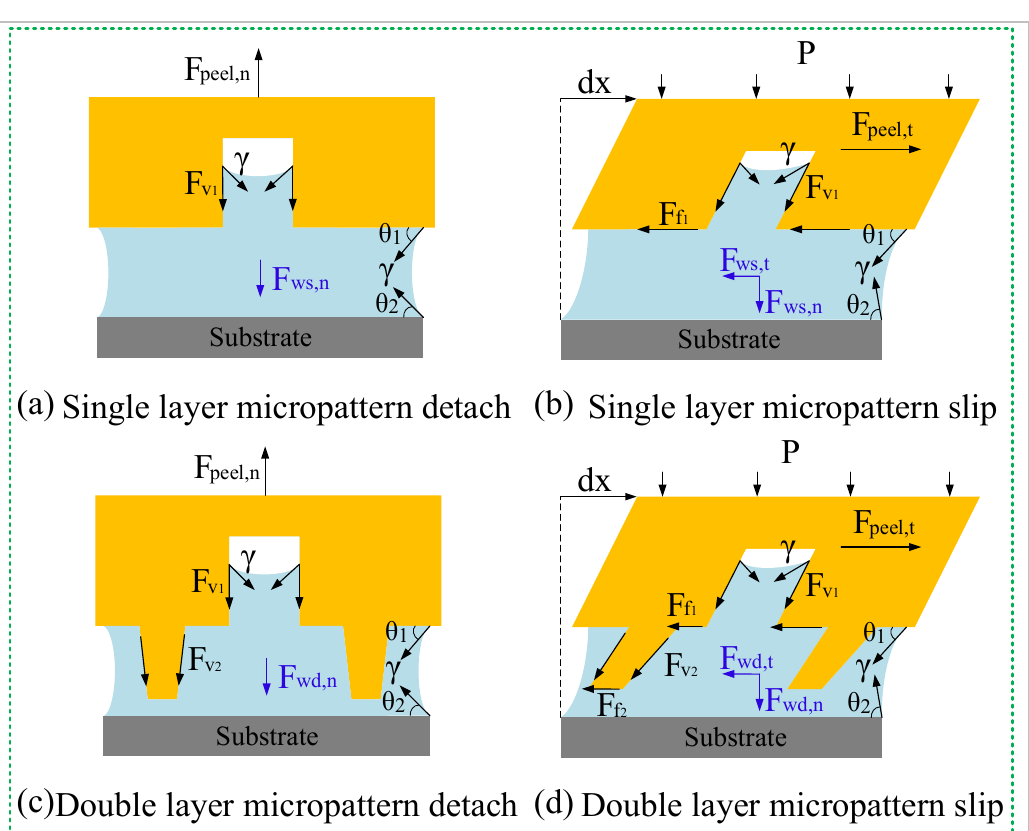
Figure 13. Diagram of the bioinspired margin in contact with the submerged substrate.